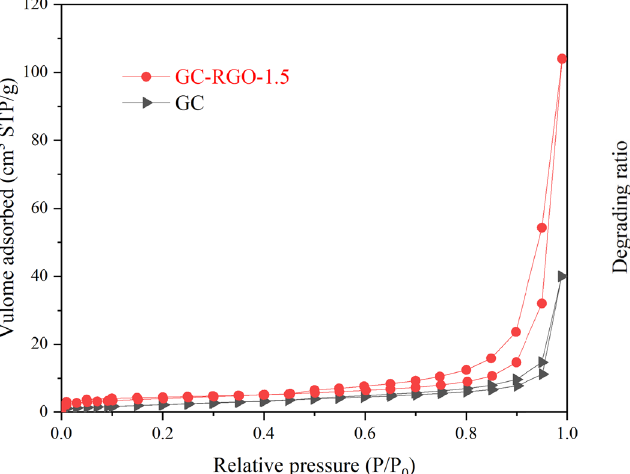
Figure 8: Nitrogen adsorption – desorption isotherms of GC and GC - RGO - 1.5.